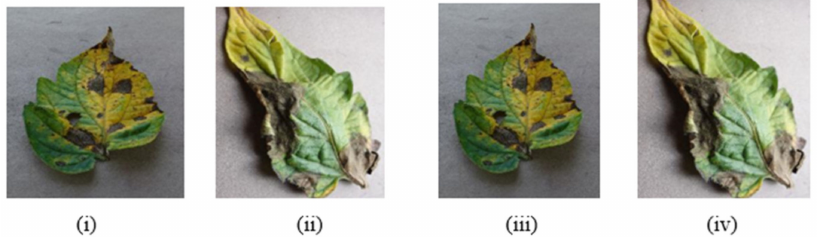
Figure 5. ( i , ii ) are the 1080 × 960-pixel of original images, whereas ( iii , iv ) are the 256 × 256-pixel reduced